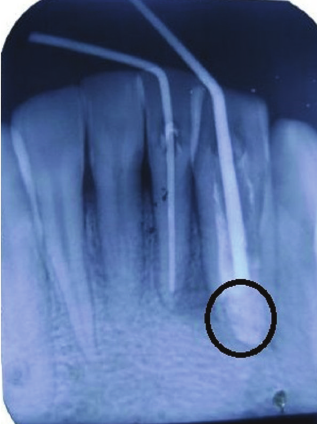
Figure 7: Radiograph showing apical plug of 4mm MTA in relation to 32 and master cone in 31.